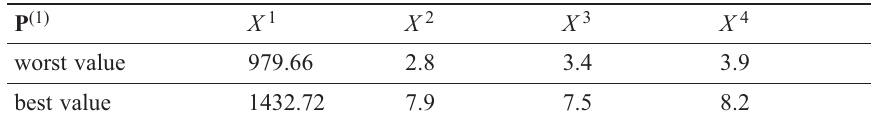
Table 1. Potency matrix P